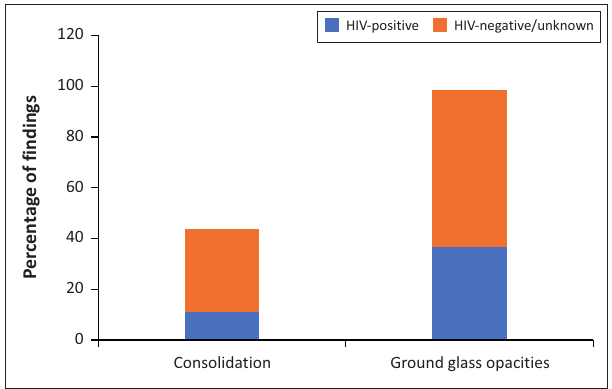
FIGURE 7: Common COVID-19 related chest radiograph findings in HIV-positive patients compared to HIV-negative patients or patients with an unknown HIV